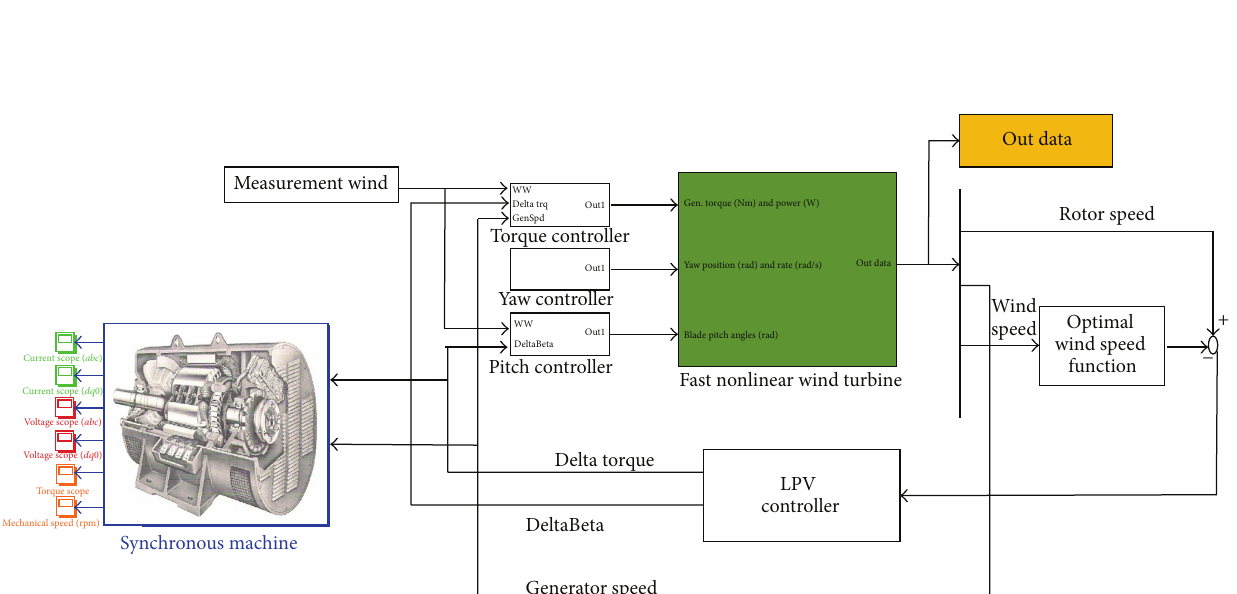
Figure 8: Closed-loop simulation of LPV control in